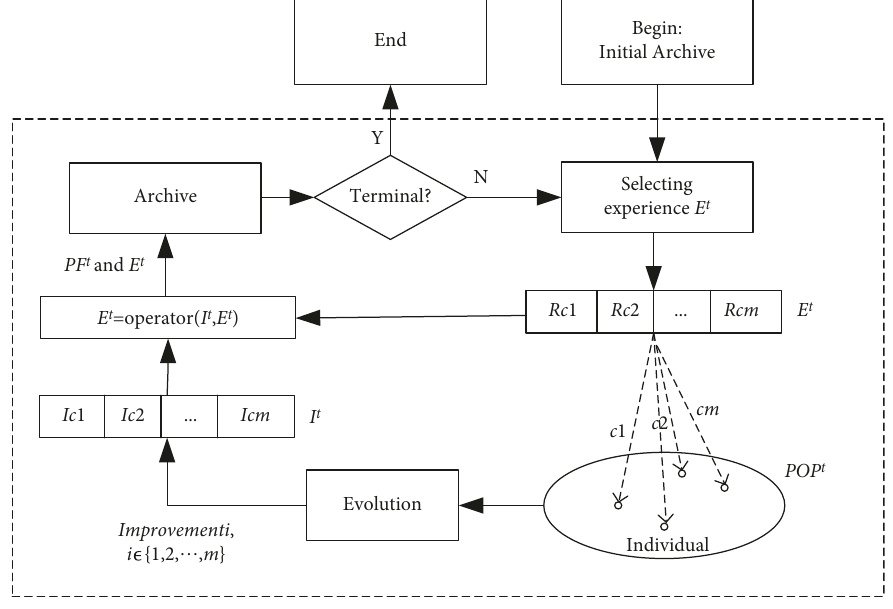
Figure 3: The architecture of the